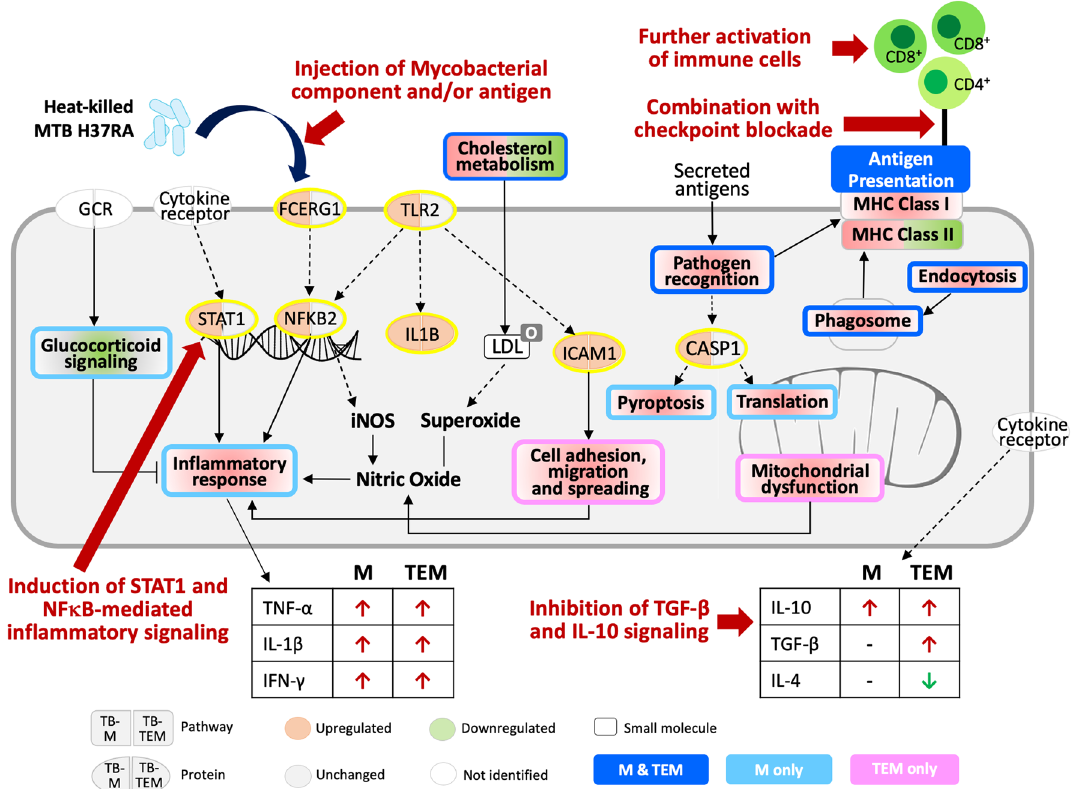
Figure 6. Summarized molecular mechanisms in heat-killed tuberculosis (HKTB)-stimulated classically activated macrophage (M) and tumor-educated macrophage (TEM) models. Based on the mechanism, we proposed alternative approaches to enhance the cancer immunotherapy using attenuated mycobacteria, as indicated by red